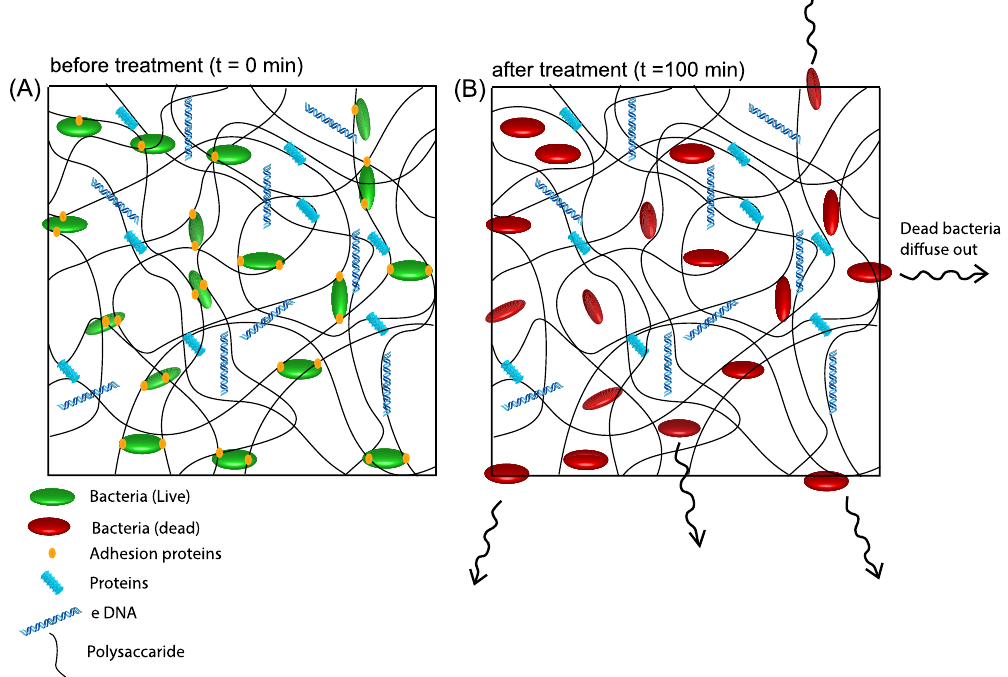
Figure 7. Model of bacterial cells embedded in the matrix comprising of polysaccharides, proteins, and DNA. ( A ) When the bacteria are alive, they act as crosslinks due to the surface adhesive proteins holding the matrix together. ( B ) When the bacteria are dead, the crosslinks are broken due to the denaturation of the surface adhesive proteins, and this leads to the swelling of the microcolonies, which eventually leads to dead bacteria passively diffusing out of the